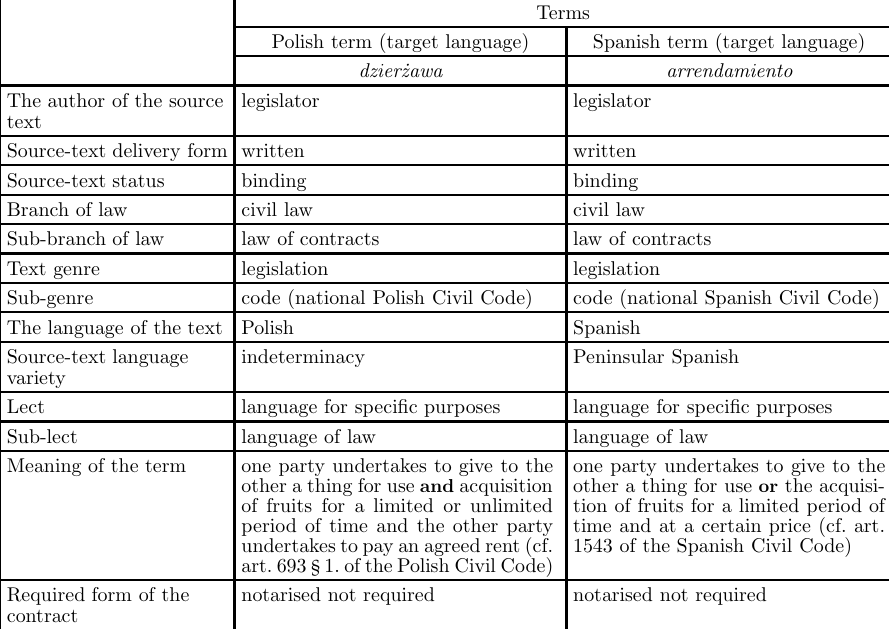
Table 3 Parametric characterisations of the Polish term dzierżawa and the Spanish term